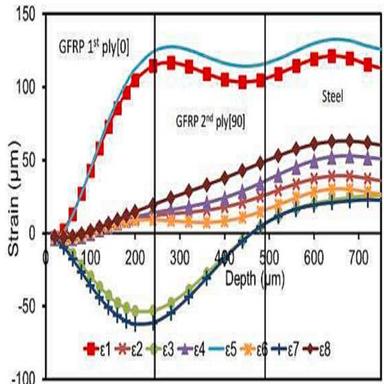
Strain data obtained for a GFRP/steel/GFRP sample using a customized 8-grid strain gauge in the IHD process.